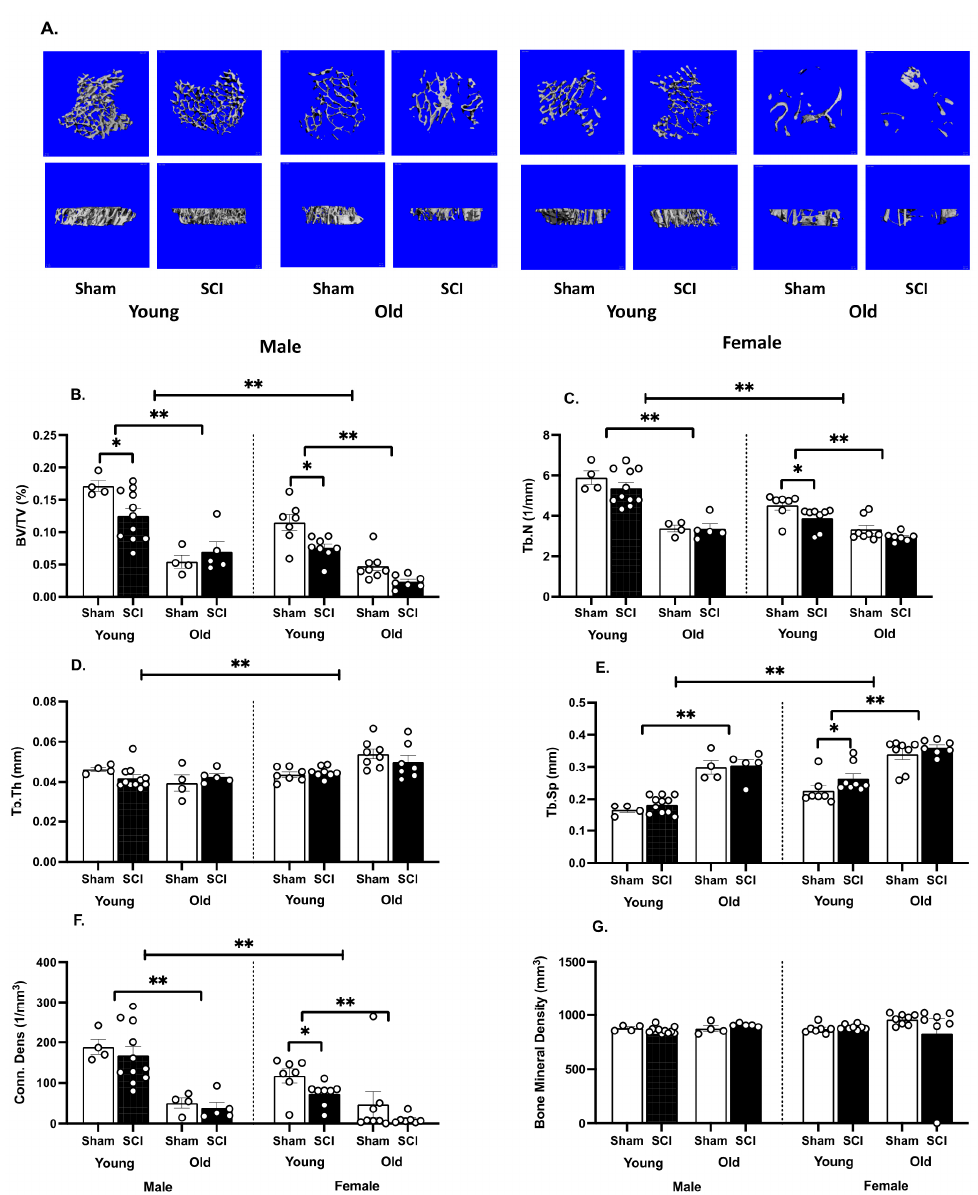
Figure 4. SCI, age, and sex affected trabecular bone. ( A ). Coronal ( top panels) and lateral ( bottom panels) view of microCT 3D reconstructions of 200 contiguous slices of the tibial metaphysis from a representative mouse in each group. ( B ). Females has less trabecular volume than males and, irrespective of sex, trabecular volume decreased with age. For the young subjects, SCI also decreased trabecular volume. ( C ). Females also had a reduced number of trabeculae, and the number of spicules was lower in older subjects regardless of sex. In young females there was also a decrease in trabecular number with age. ( D ). There was a main effect of sex on trabecular thickness, with females showing increased thickness relative to males. Age and sex did not affect this parameter. ( E ). Sex, age and SCI affected trabecular spacing. Spacing increased in females, relative to males, and in older subjects relative to young. SCI increased trabecular spacing in the young females. ( F ). Connective density was also greater in males relative to females, and in young compared to old mice. SCI decreased connective density in young females. ( G ). There was no effect of sex, age or SCI on bone mineral density. Means ± SEMs are plotted for each group. Individual subjects are shown with the round, white symbols. n = 4 sham and 5 SCI old males; 4 sham and 11 SCI young males; 8 sham and 7 SCI old females; 7 sham and 8 SCI young females. ** p < 0.01, * p <